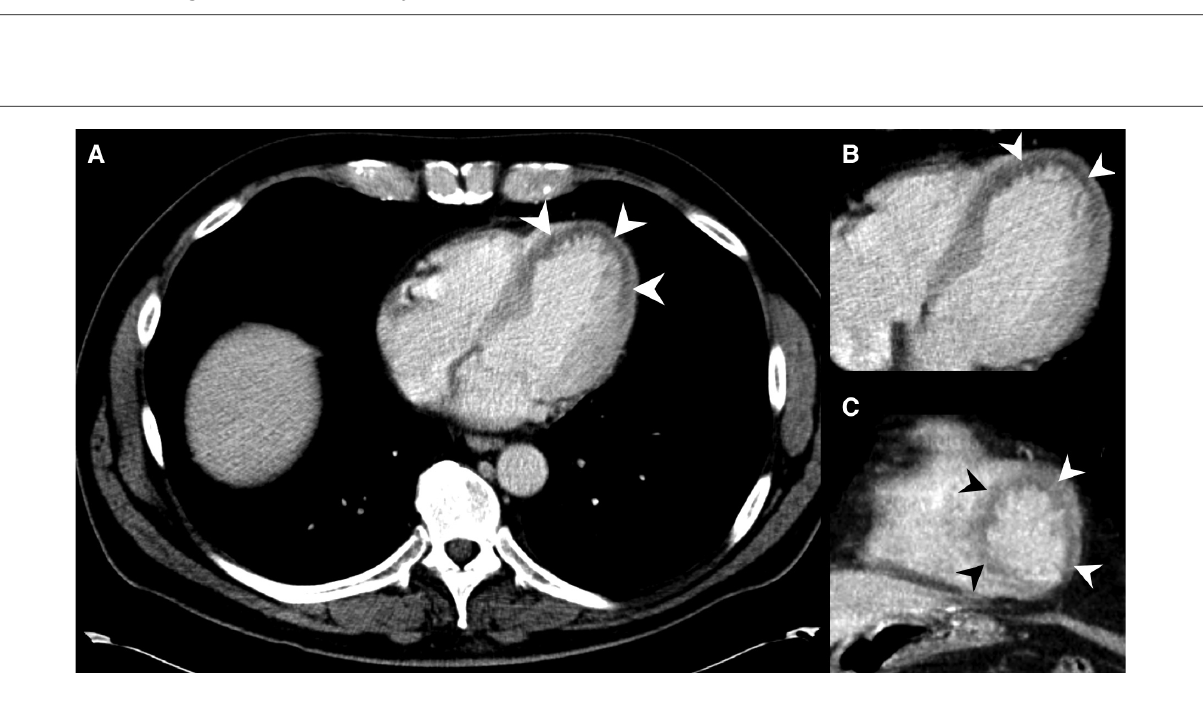
FIGURE 3 MDCT of a 53-year-old male presenting pain in the chest and upper abdominal area. MH is noted at the left ventricle at the heart apex on axial slices ( A , B ) and on coronal reformations ( C ) (arrowheads), but was not described in the radiological report. Emergency doctors clinically suspected MI about one hour after the MDCT, and the patient was transferred to PTCA shortly after. The patient could be discharged from hospital after a few more days.